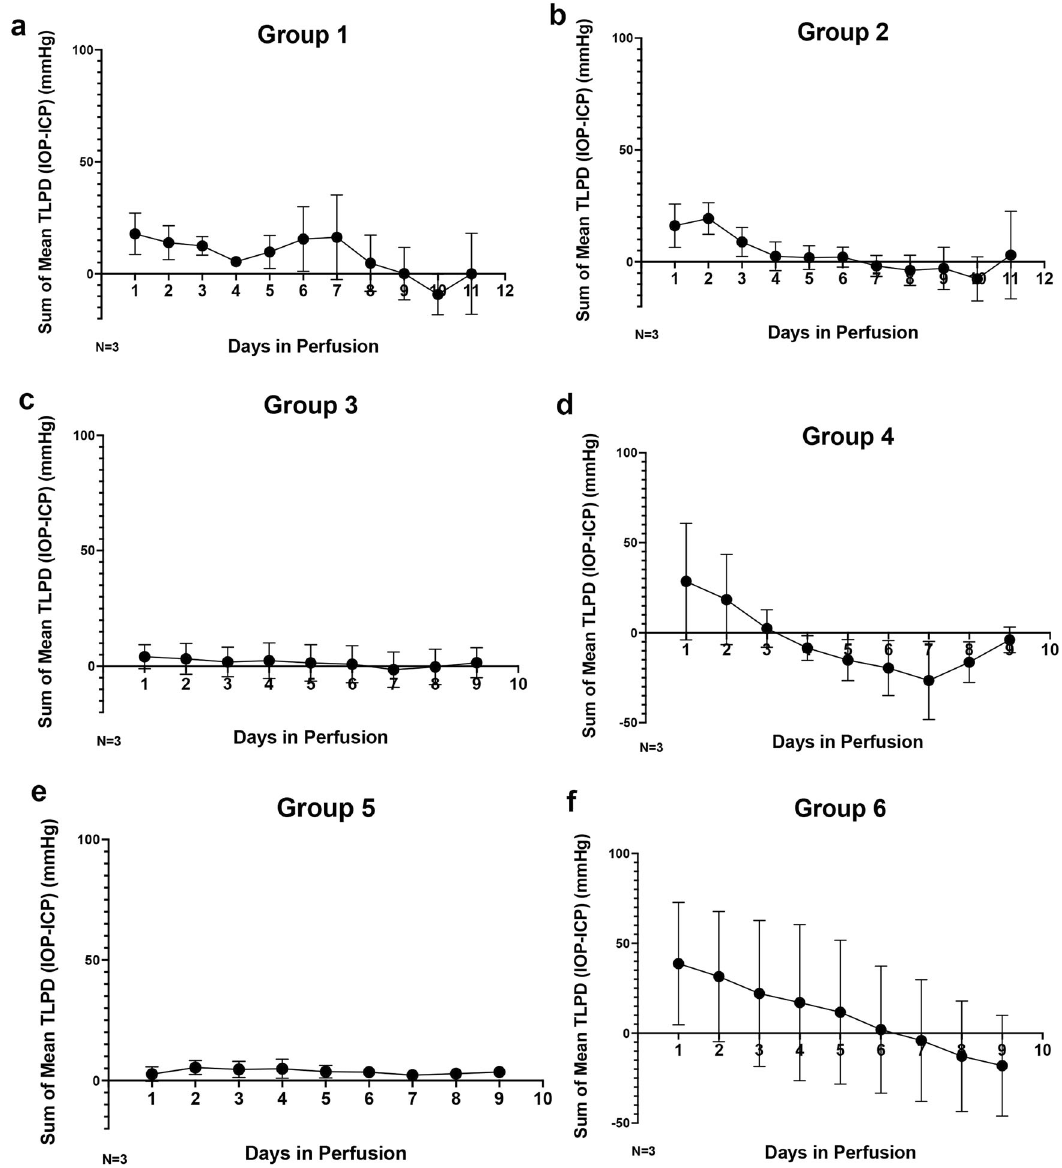
Fig. 1 Maintenance of translaminar pressure difference. Graphical representation of sum of mean TLPD (difference in mmHg of IOP-ICP every 24 h) pressures being maintained for ( a ) Group 1, ( b ) Group 2, ( c ) Group 3, ( d ) Group 4, ( e ) Group 5 and ( f ) Group 6. ICP intracranial pressure, IOP intraocular pressure, TLPD translaminar pressure difference, N = 3. Data are presented as mean ± standard error of the mean and P < 0.05 was considered statistically signi fi